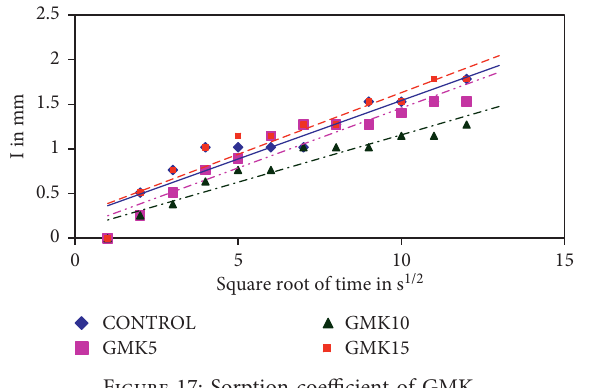
Figure 17: Sorption coefficient of GMK.